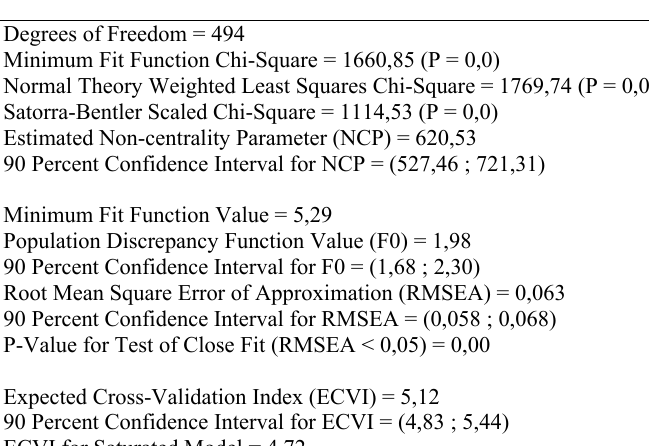
Table 9: Goodness of fit